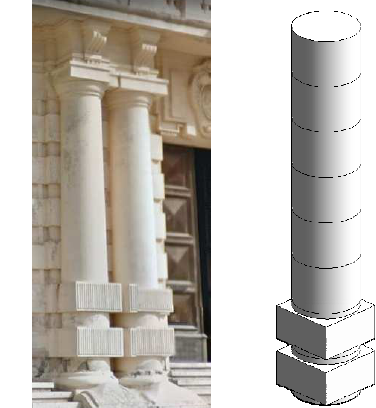
Figure 15. Application of the string based dislocation in Palazzo delle Scienze (Cagliari)